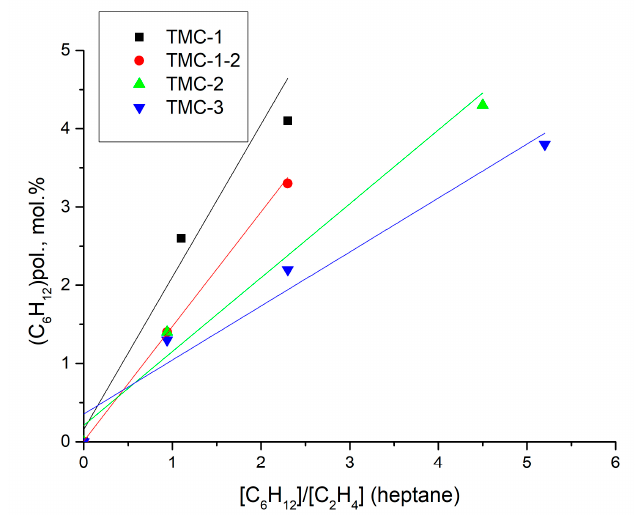
Figure 2. The content of 1-hexene in C 2 /C 6 copolymers obtained on TMC of different compositions versus the [C 6 H 12 ]/[C 2 H 4 ] ratio in the reaction medium (heptane) (for polymerization conditions and the catalyst’s number, see Table 2).